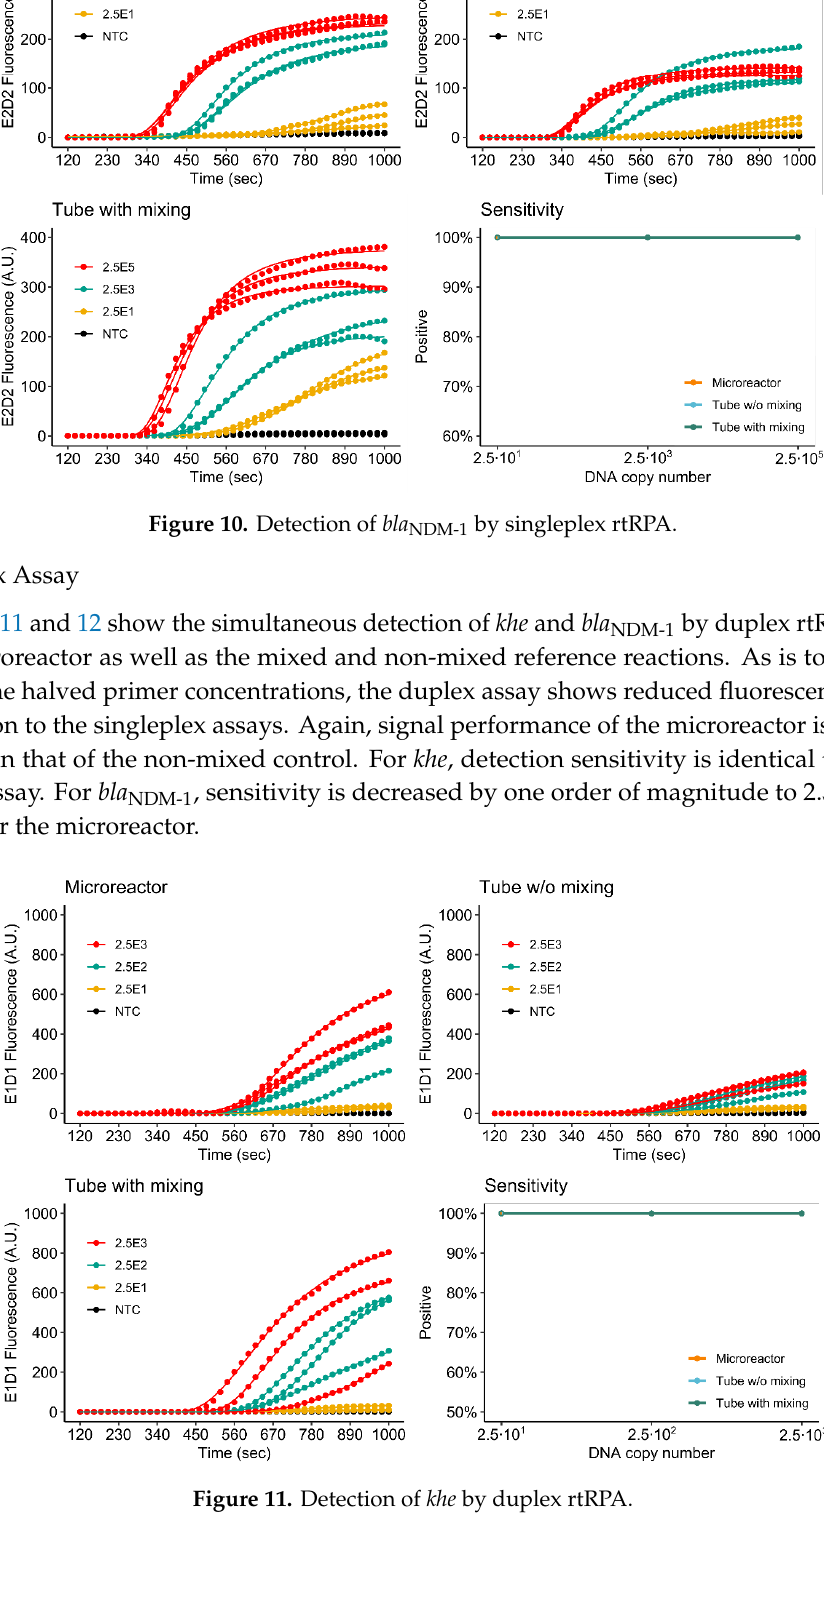
Figure 12. Detection of bla NDM-1 by duplex rtRPA. 3.4.3. Comparison of Single- and Duplex Assays